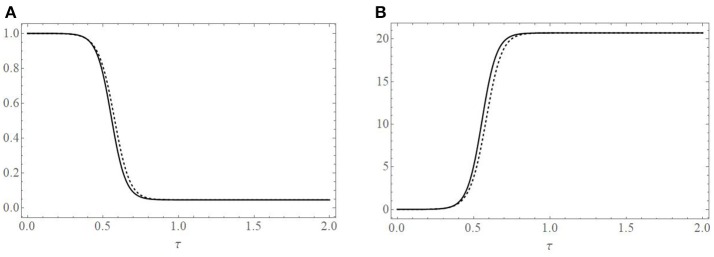
Comparison of the asymptotic solution of the cell population (solid black line), (A), and EIAV population (solid black line), (B), with a numerical simulation (dashed line) of Equations (2). Parameters used to create the plots are given in the text and correspond to R0 = 21.7 and ε = 0.007.